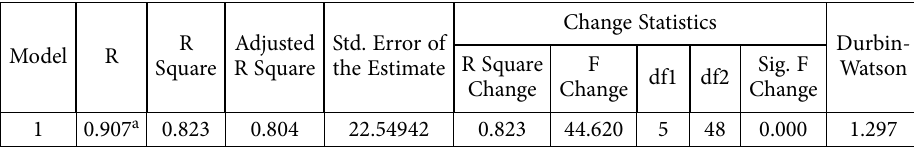
Table 3. Seasonal sustainability function for 2015